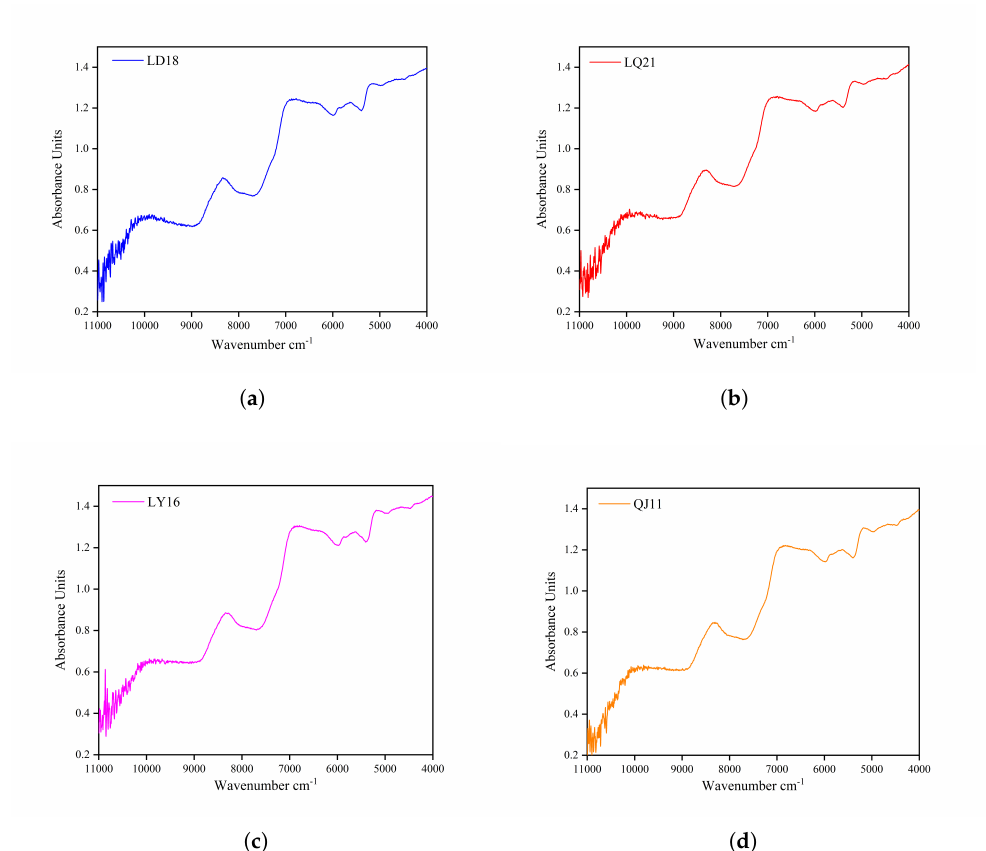
Figure 3. Original Fourier transform near-infrared (FT-NIR) Spectrogram of four rice varieties. Where the rice varieties corresponding to the results shown in sub-figures ( a – d ) are Longdao 18, Longqingdao 21, Longyang 16, Qijing 11